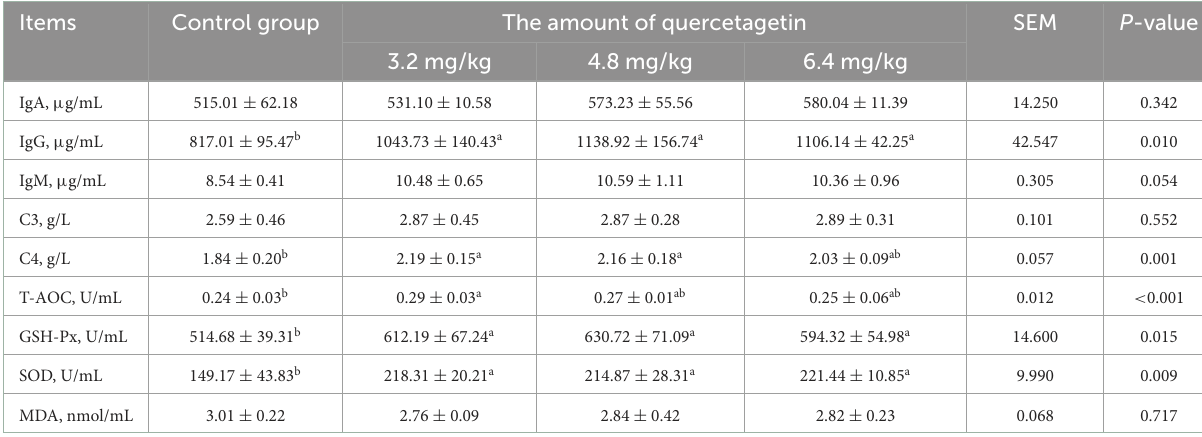
TABLE 6 Effect of quercetagetin on serum biochemical indices of